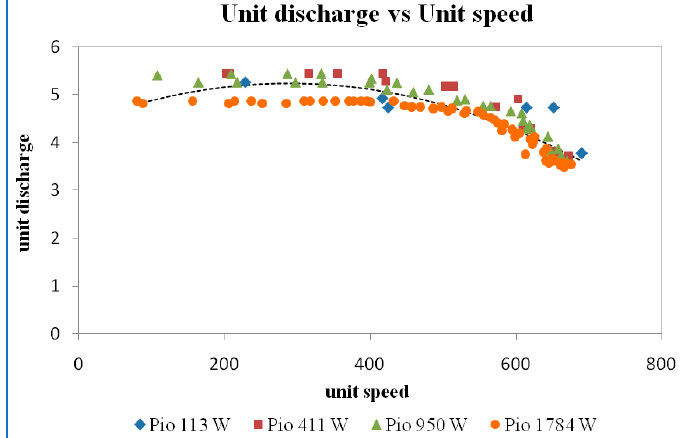
Figure 31. Unit discharge vs. unit speed at a guide vane opening of 16 mm.